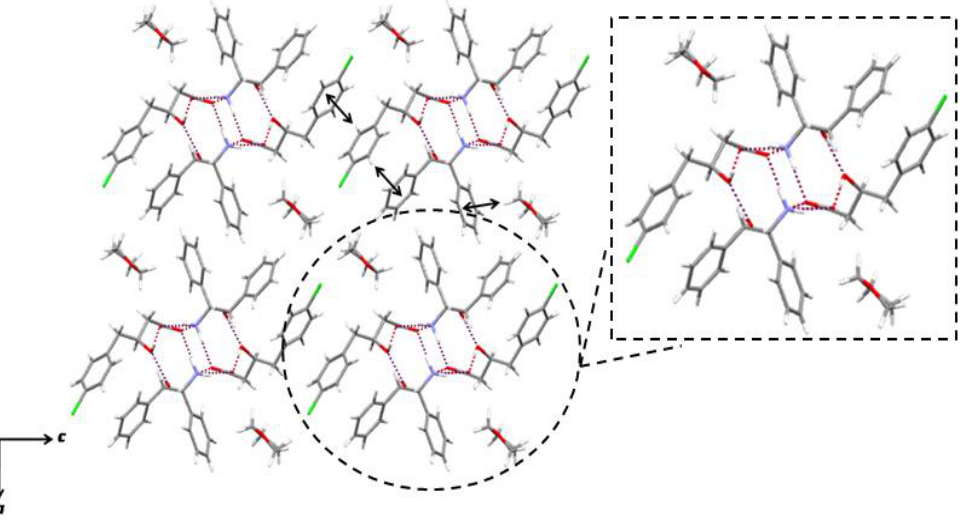
Figure 2. The ( S )- 2 · (+)-ADPE salt obtained in THF, viewed from the b -axis. The dotted lines and arrows indicate hydrogen bonds and CH/ π interactions, respectively.